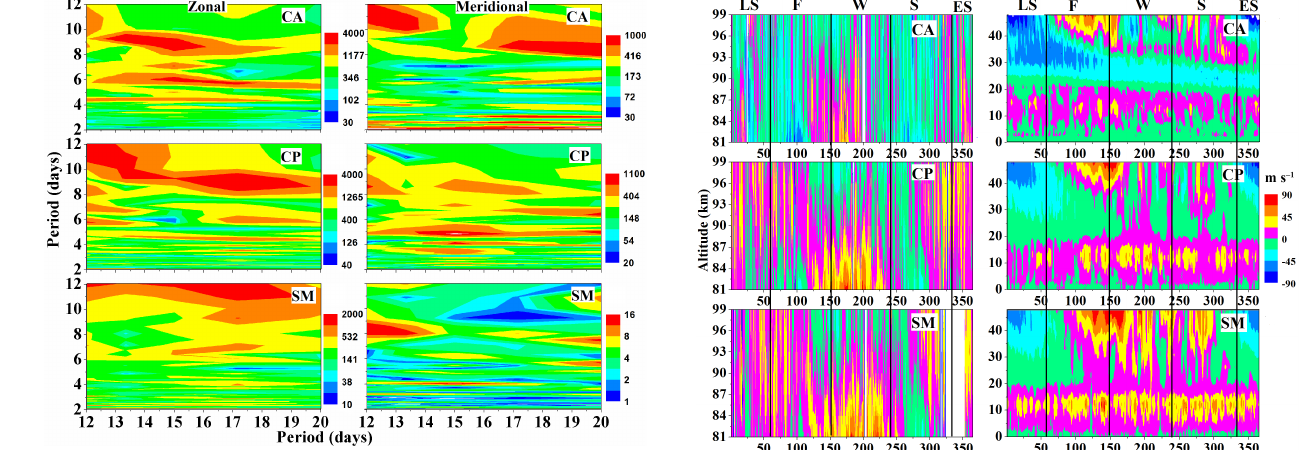
Figure 10. Temporal variability of the zonal wind in the MLT and TS at three